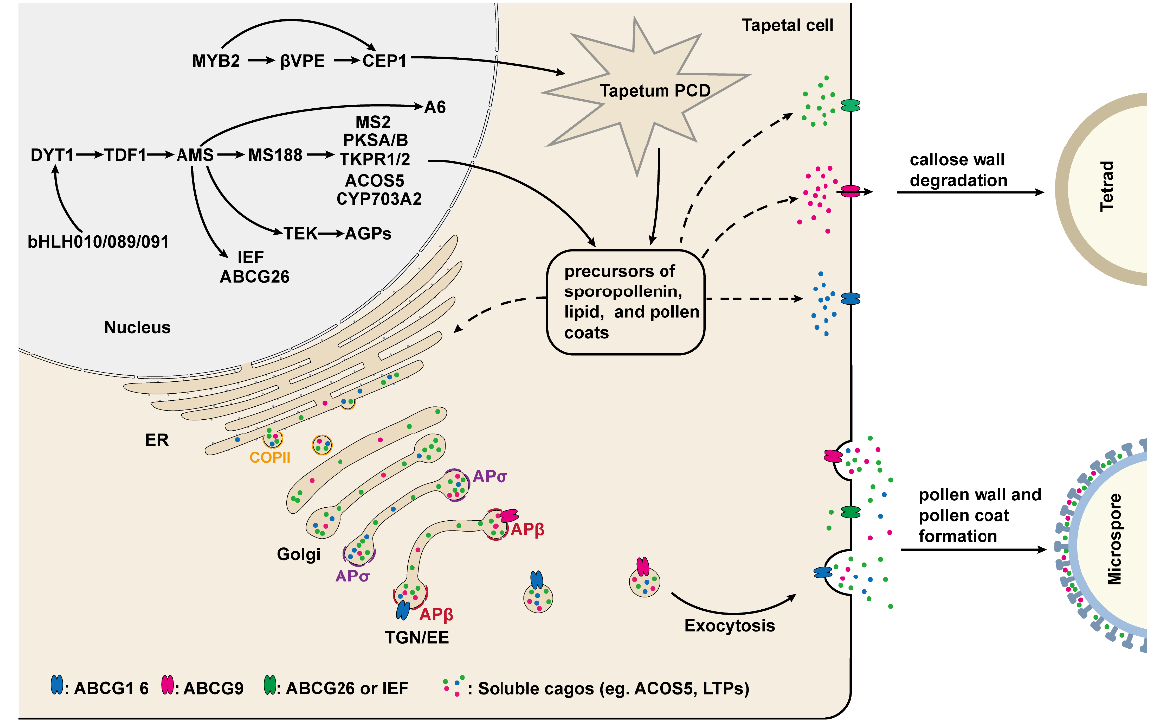
Figure 2. The underlying molecular mechanism of tapetum-mediated pollen development. The development and function of the tapetum are mainly regulated by a series of transcription factors. These transcription factors regulate the expression of genes required for the production of enzymes, transporters, and the precursors of sporopollenin, lipids, and pollen coats, which are indispensable for callose wall degradation, microspore development, and pollen wall and pollen coat formation. The secretion of these materials and precursors from tapetum cells to the anther locule is dependent on COPII and AP-mediated vesicle trafficking pathway.